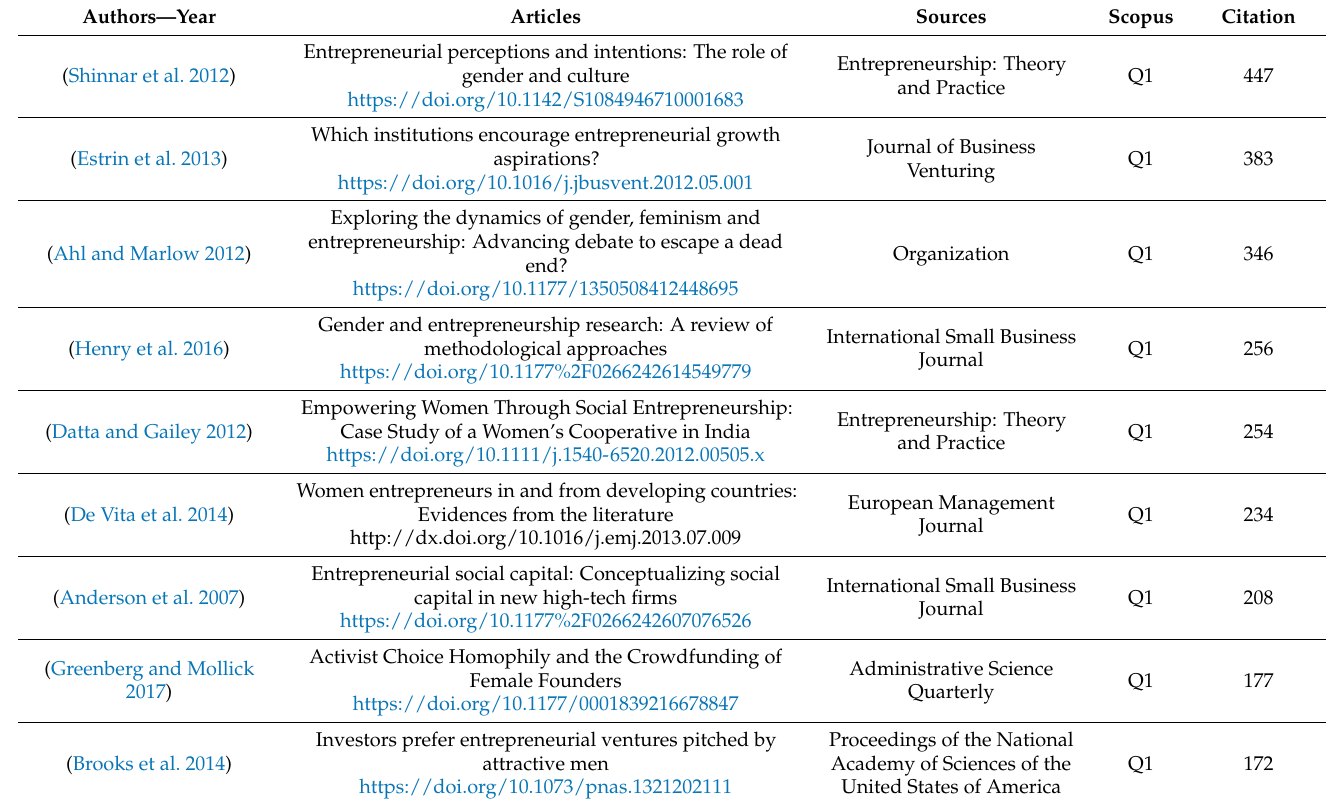
Figure 7. Authorship co-occurrence map. Table 3. Twenty articles with the highest number of citations.